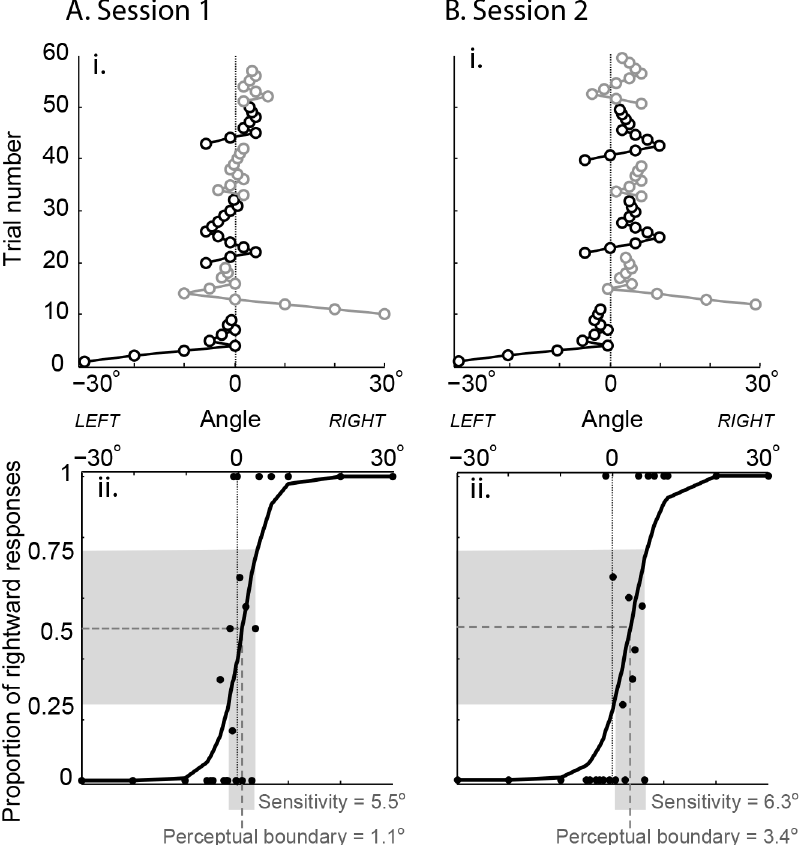
Fig 2. Adaptive staircase performance of a young subject (age 21) in two sessions conducted 10 days apart. A. i. Subject performance on 6 staircases in session 1: trial number vs. angle of the white line relative to true index finger angle (0°). Black: staircases that began with a leftward trial. Grey: staircases that began with a rightward trial. ii. Proportion of rightward responses at each tested angle (black circles) with fitted function. Perceptual boundary (proprioceptive bias) was 1.1°, proprioceptive sensitivity (width of grey shaded area on x-axis) was 5.5°. B. i. Subject performance 10 days later on 6 staircases. ii. Both perceptual boundary and sensitivity (3.4° and 6.3°, respectively) appear similar to the first